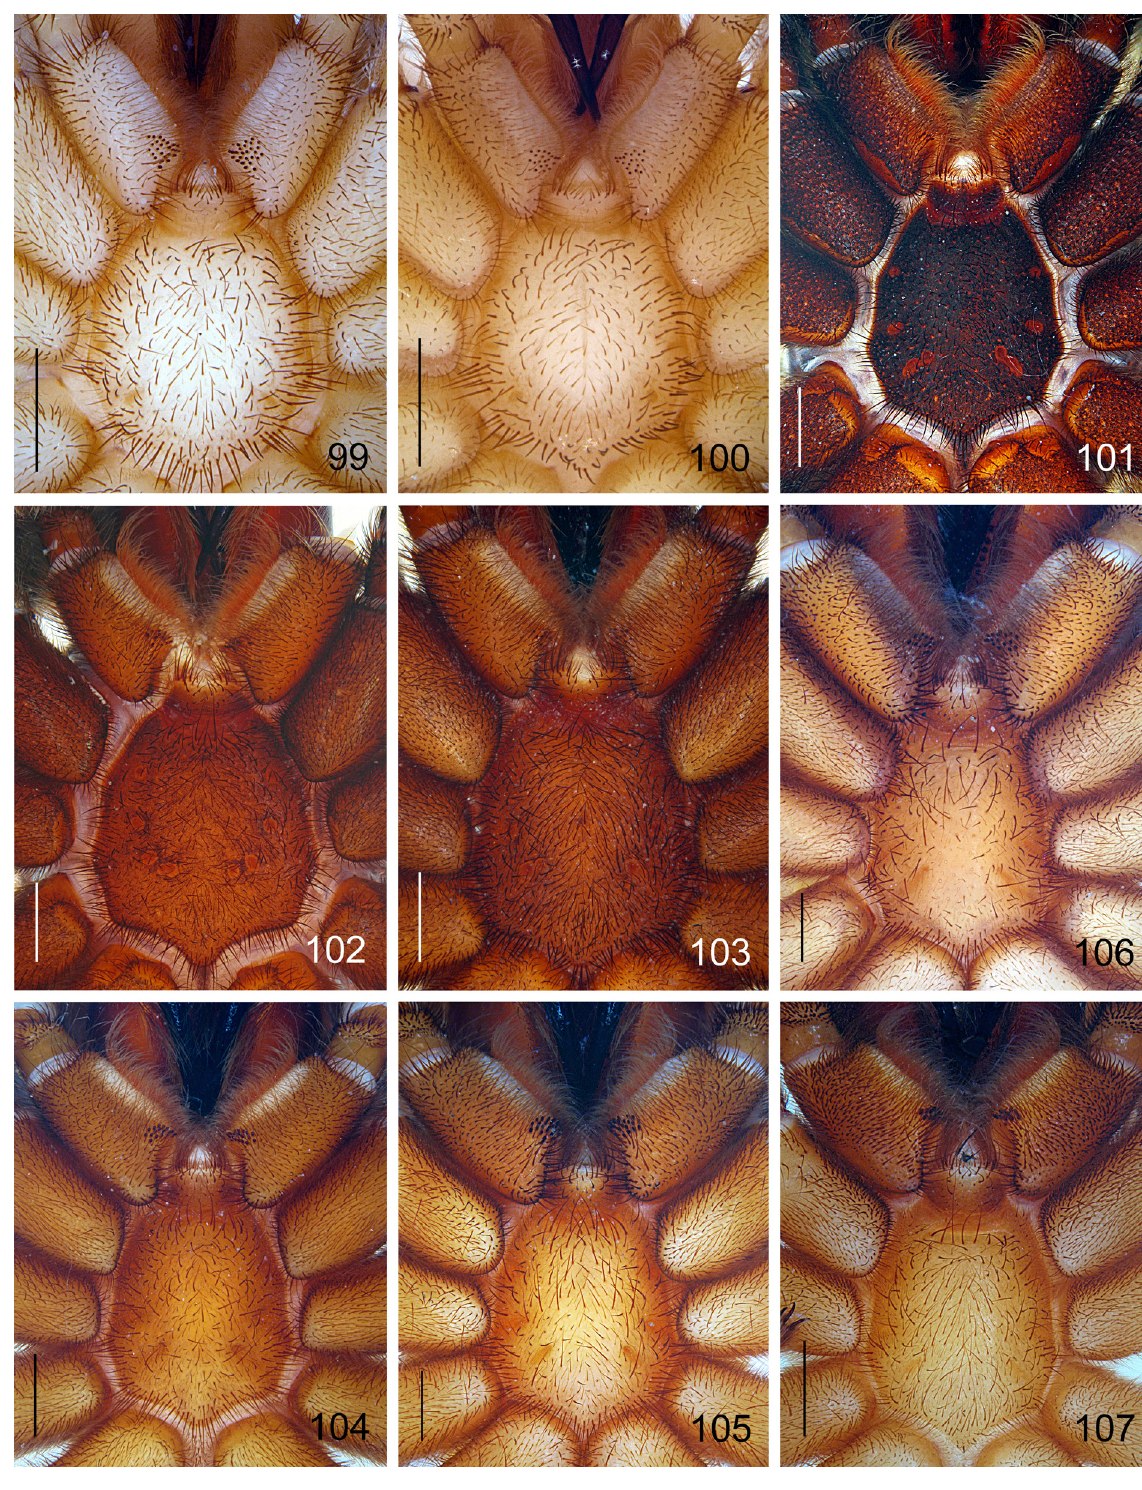
Figs 99–107. Anemesia spp., ♂♂ (99–103) and ♀♀ (104–107), sternum, labium and maxillae, ventral views. 99 . A. pallida sp. nov. (holotype). 100 . A. parvula sp. nov. (holotype). 101 . A. incana Zonstein, 2001 (holotype). 102 . A. infumata sp. nov. (holotype). 103 . A. infuscata sp. nov. (holotype). 104 . A. birulai (Spassky, 1937) (Kepele). 105 . A. pococki sp. nov. (paratype). 106 . A. tubifex (Pocock, 1889) (Kalaimor). 107 . A. andreevae sp. nov. (paratype, Babatag Mts). Scale bars: